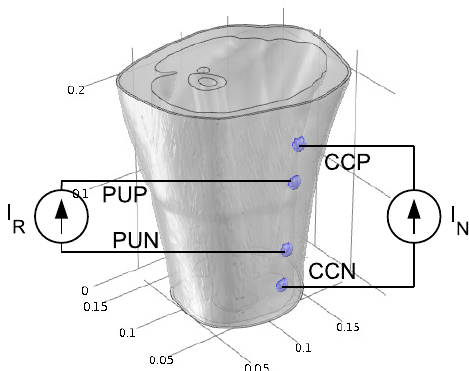
Fig. 23: Measurement set-up for exploring the principle of reci- procity. This set-up has current stimuli on both outer and inner electrode pairs. This set-up is not used for direct